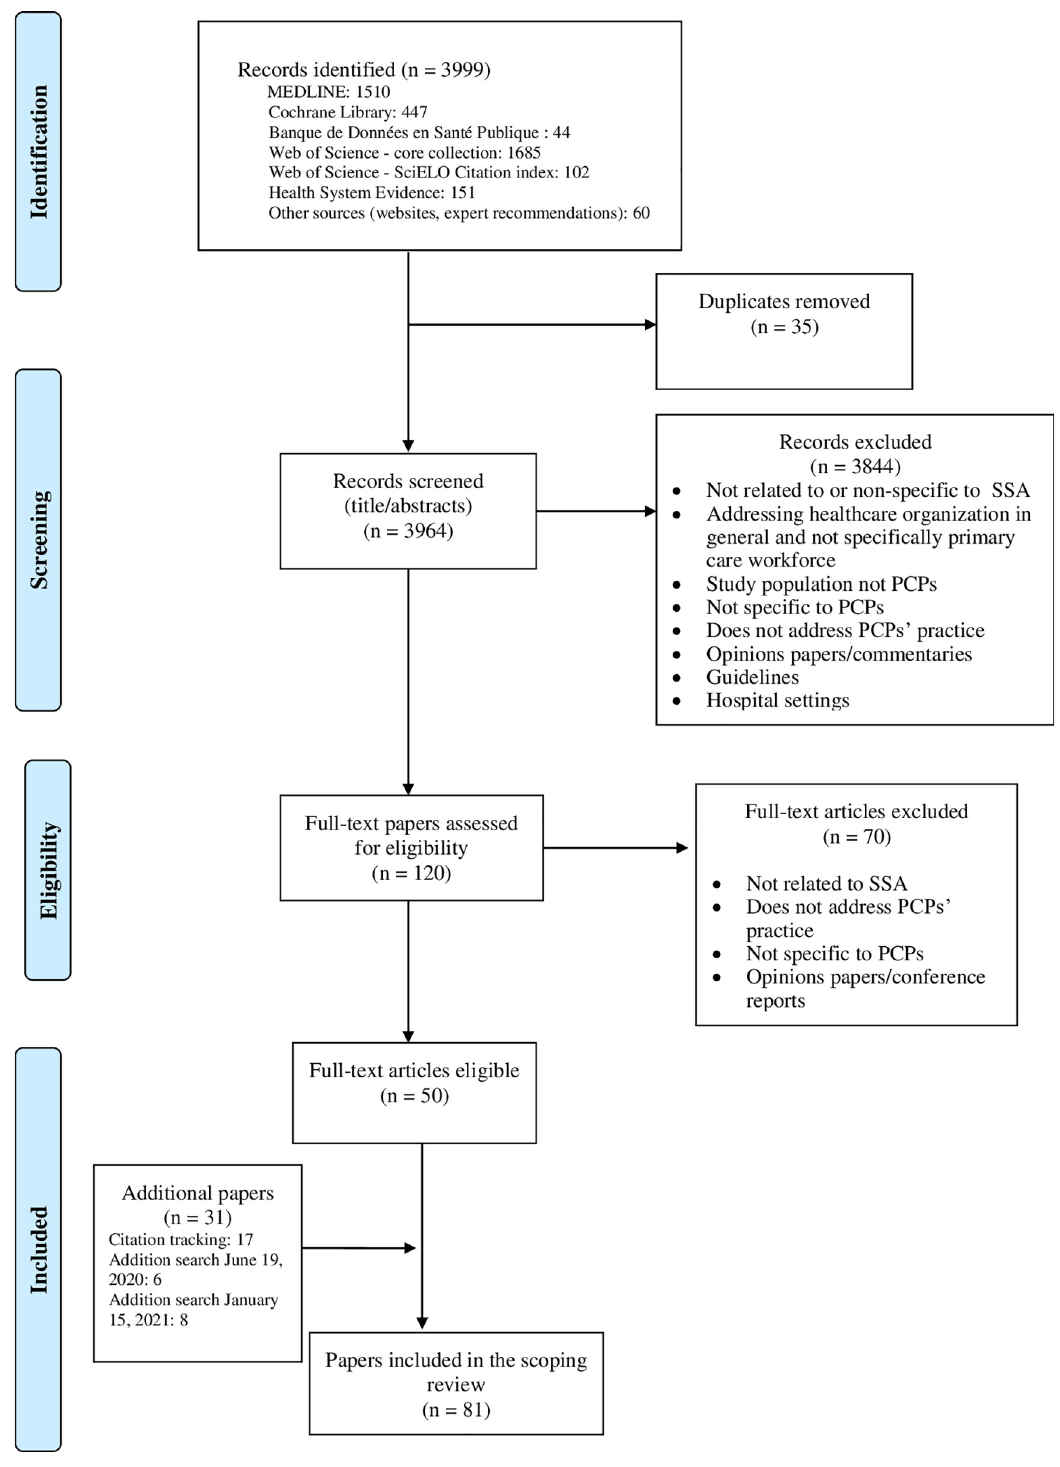
Fig 1. Flowchart of the study